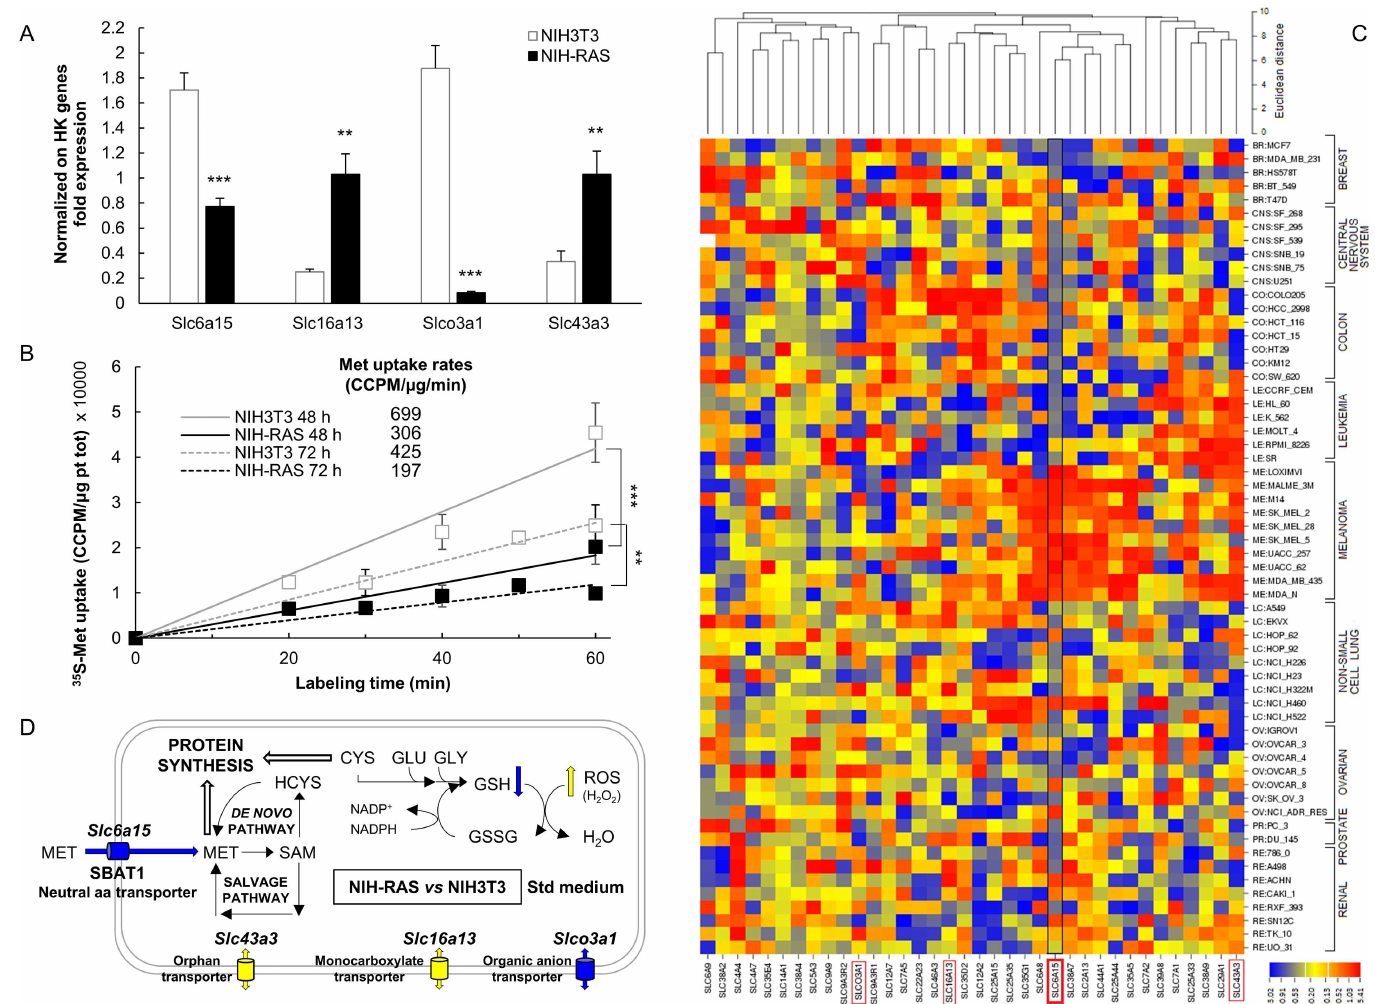
Fig 4. Methionine transport and solute carrier expression in mouse fibroblasts and in NCI-60 panel. (A) Semiquantitative RT-PCR results for NIH3T3 and NIH-RAS cells grown for 48 h in standard medium performed in triplicate on genes showingat least a two-fold changebetween NIH-RAS vs NIH3T3 cells in each of the two Affymetrix independent experiments (S5 Fig). (B) Labeledamino acid ( 35 S-methionine) uptake rate in exponential and confluentcells (48 and 72 h of growth in standard medium, respectively), measured after 20’-40’-60’ (for exponentialcells) and after 30’-50’-60’ (for confluentcells) of labelingwith 0.025 mCi/ml 35 S-Met. Radioactivity values, expressed as CCPM (corrected counts per minute), were normalizedon total protein content and plotted against labelingtime. Results are mean +/- standard deviationof three independent experiments. ** P < 0.01; *** P < 0.001 (Student’s t -test). (C) The mRNA expressiondata for the NCI-60 human tumor cell lines were retrieved from CellMiner relationaldatabase [59]. These expression data were inputted in CIMminer [60] to generatea heat map, as describedin Materials and Methods. Here are highlightedthe names of the genes whose expression was statistically different between NIH3T3 and NIH-RAS cells, with a particular emphasison the data related to SLC6A15 gene. (D) Concept map of cysteine and methioninemetabolism in NIH3T3 and NIH-RAS